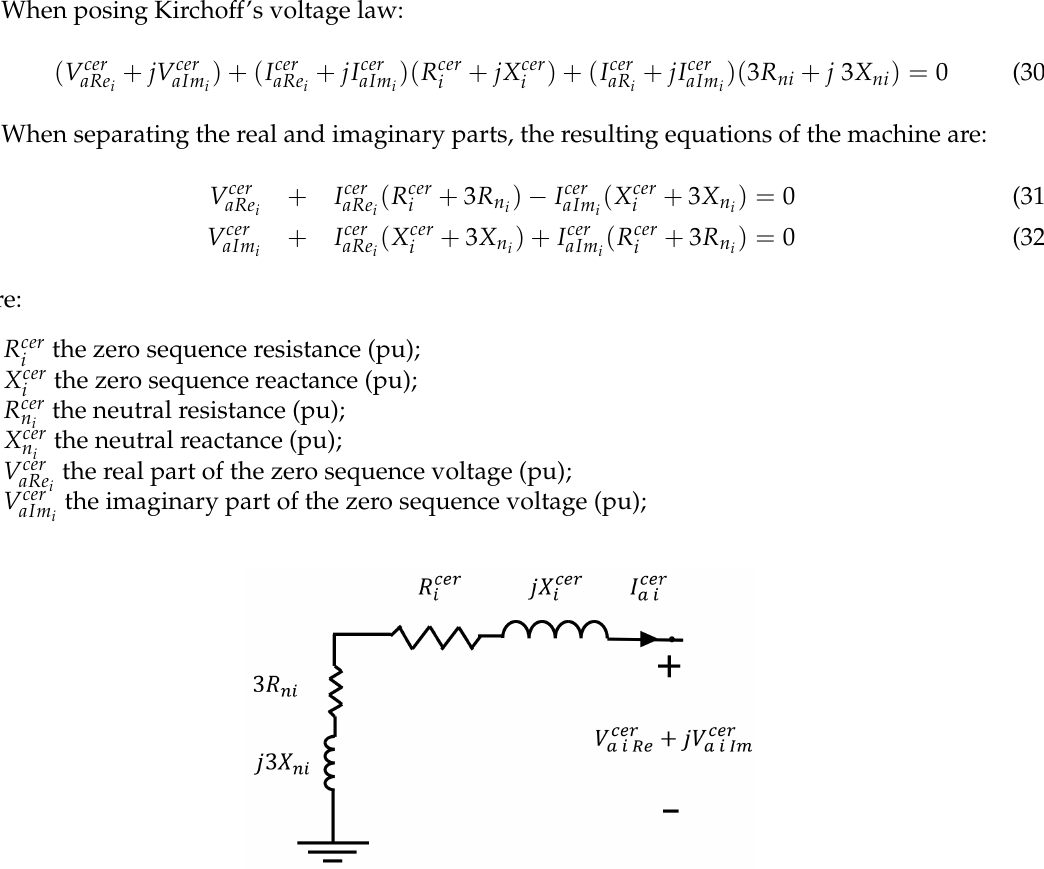
Figure 3. Circuit of the zero sequence for the multimachine case